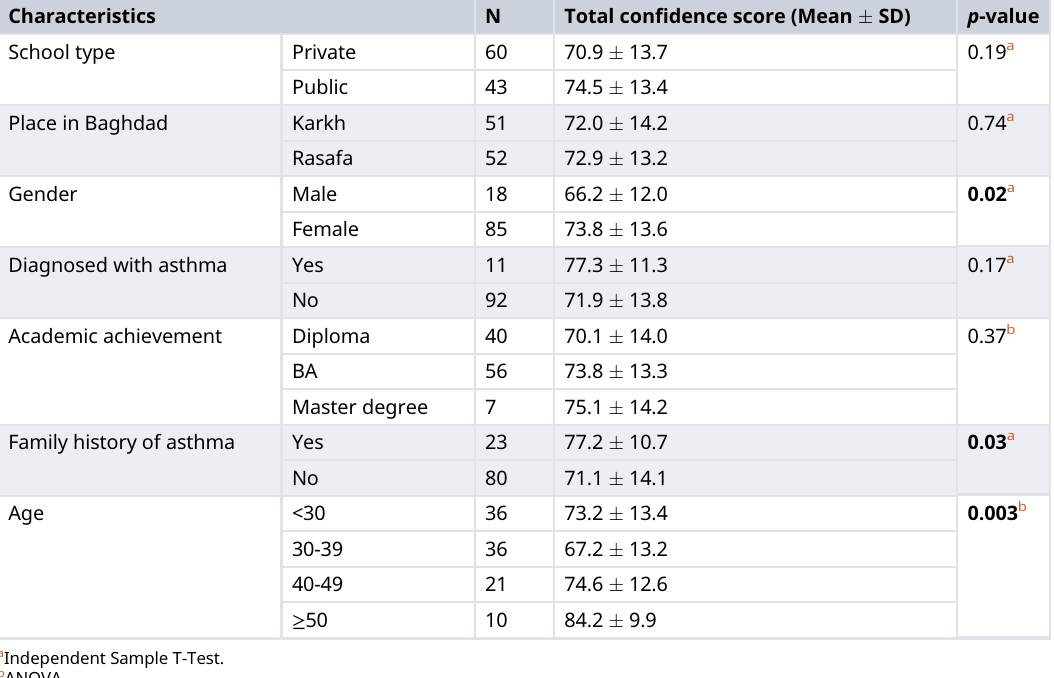
Table 4. Association between the total confidence score and sociodemographic characteristics of primary school teachers. Characteristics